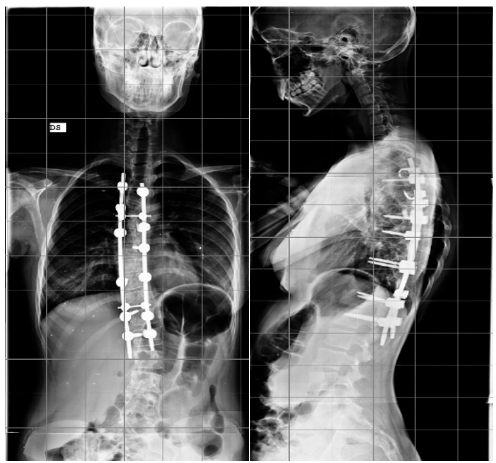
Figure 2. Example of hybrid construct for the treatment of AIS, AP, and